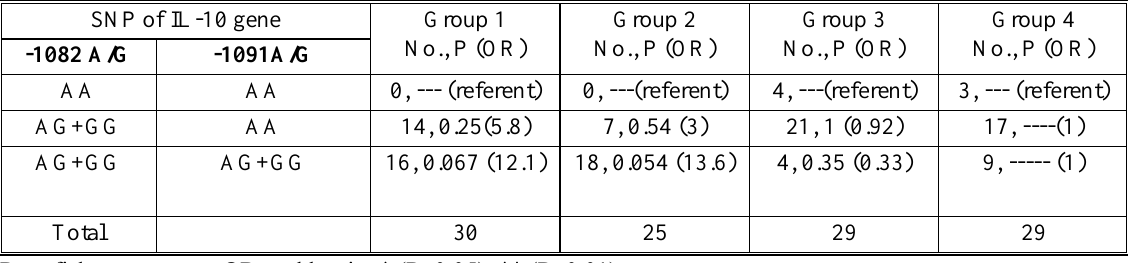
Table 2. The interaction between two single nucleotide polymorphisms (SNPs) at positions -1082 A/G and 1091 A/G of the interleukin 10 (IL-10) gene in different groups.